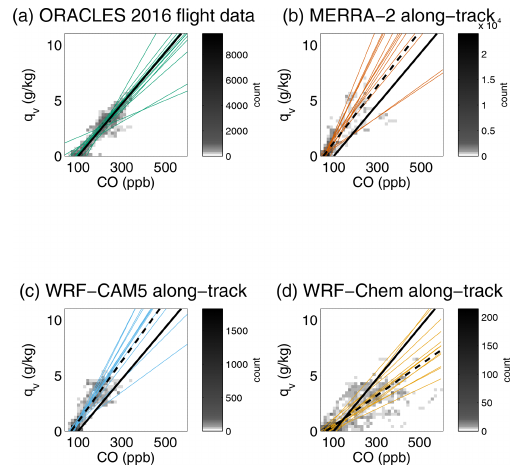
Figure 7. CO vs. q from (a) aircraft observations ( R 2 = 0 . 78), (b) MERRA-2 reanalysis ( R 2 = 0 . 56), (c) WRF-CAM5 ( R 2 = 0 . 71), and (d) WRF-Chem ( R 2 = 0 . 49) for all flights, for altitudes z > 2km. Individual colored lines show the total least-squares fits for individual flights, and the black lines show the averages of all observed flights (solid) compared to each model